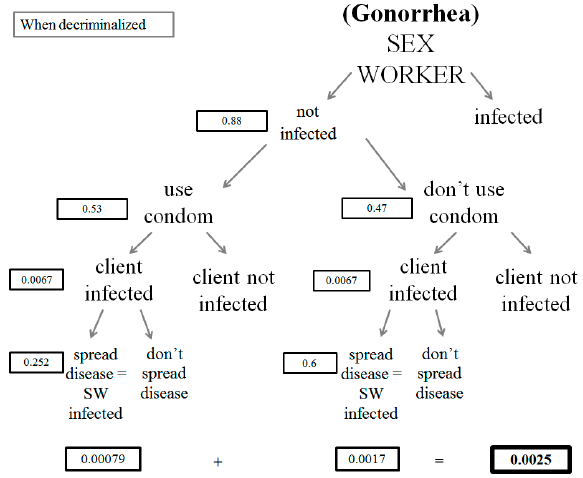
Figure A8. Risk of gonorrhea transmission to a sex worker under criminalization.